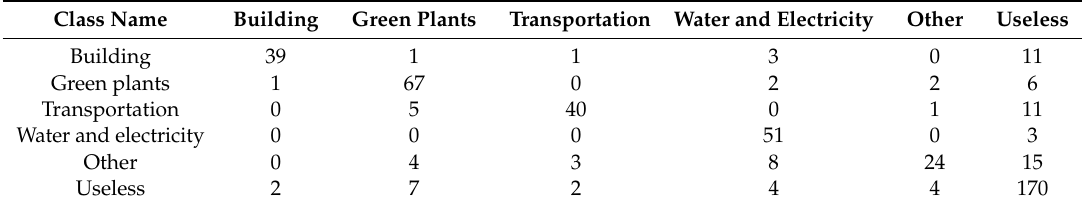
Table 4. Confusion